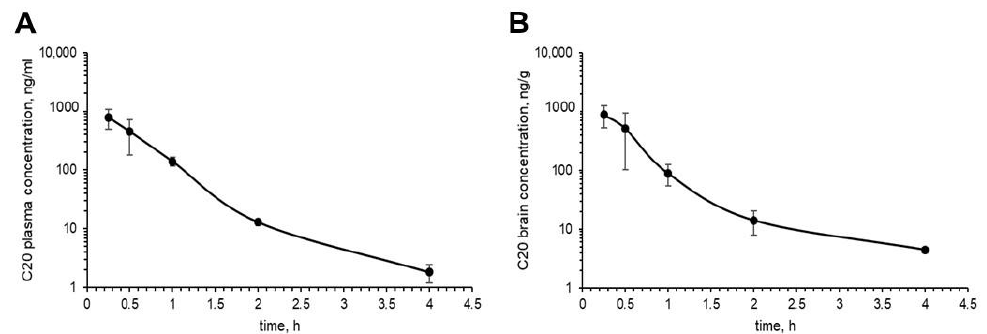
Figure 5. In vivo pharmacokinetics of C20. C20 was i.p. injected into mice at 10 mg/kg dose. ( A ) The pharmacokinetic profile of C20 in blood plasma samples. ( B ) C20 efficiently penetrates BBB. After 4